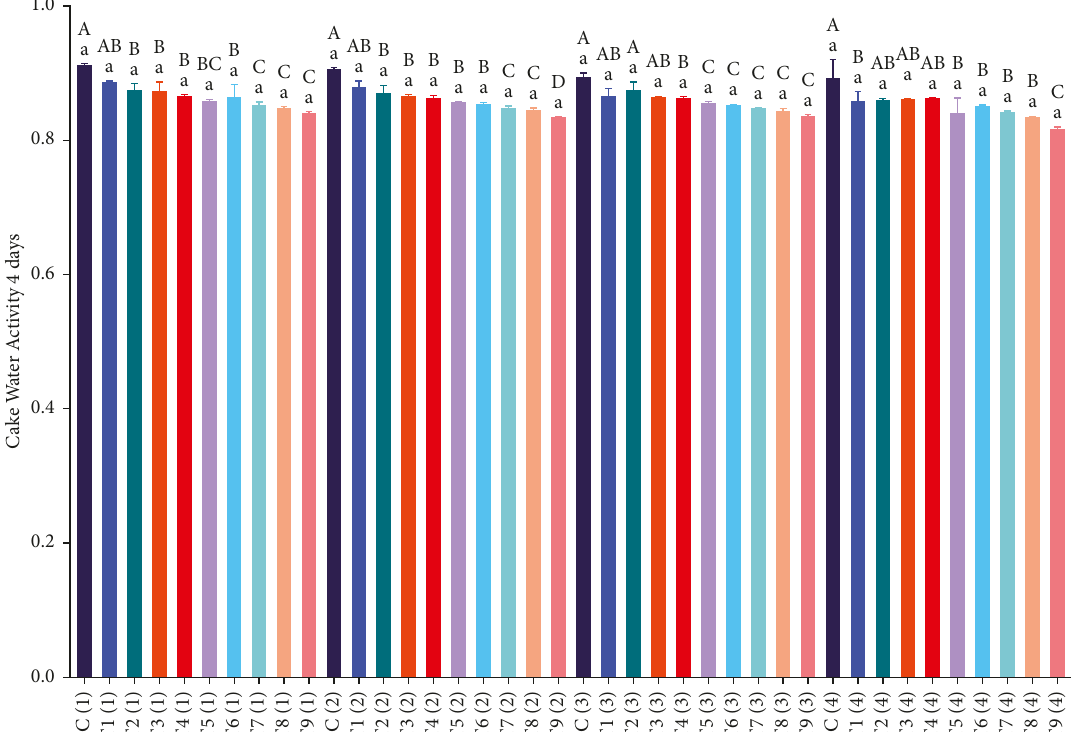
Figure 2: Comparison of water-activity of quinoa cake treatments and control. Water activity of cakes was measured on homogenized samples with an electronic hygrometer at 25 0.2 ° C. Samples were collected from the middle section of each cake. The data are expressed as mean SD from at least three separate experiments. Inter-group comparisons were made using one way ANOVA.The same lowercase letters indicate no significant changes of a treatment’s aw during four-day period at p 0 . 05 probability level. Different capital letters indicate the ± significant difference between treatments’ aw in the same day compared to each other at p 0 . 05 probability level. ± < < Table 5: Approximate values of Physical & textural properties of quinoa cake treatment s .